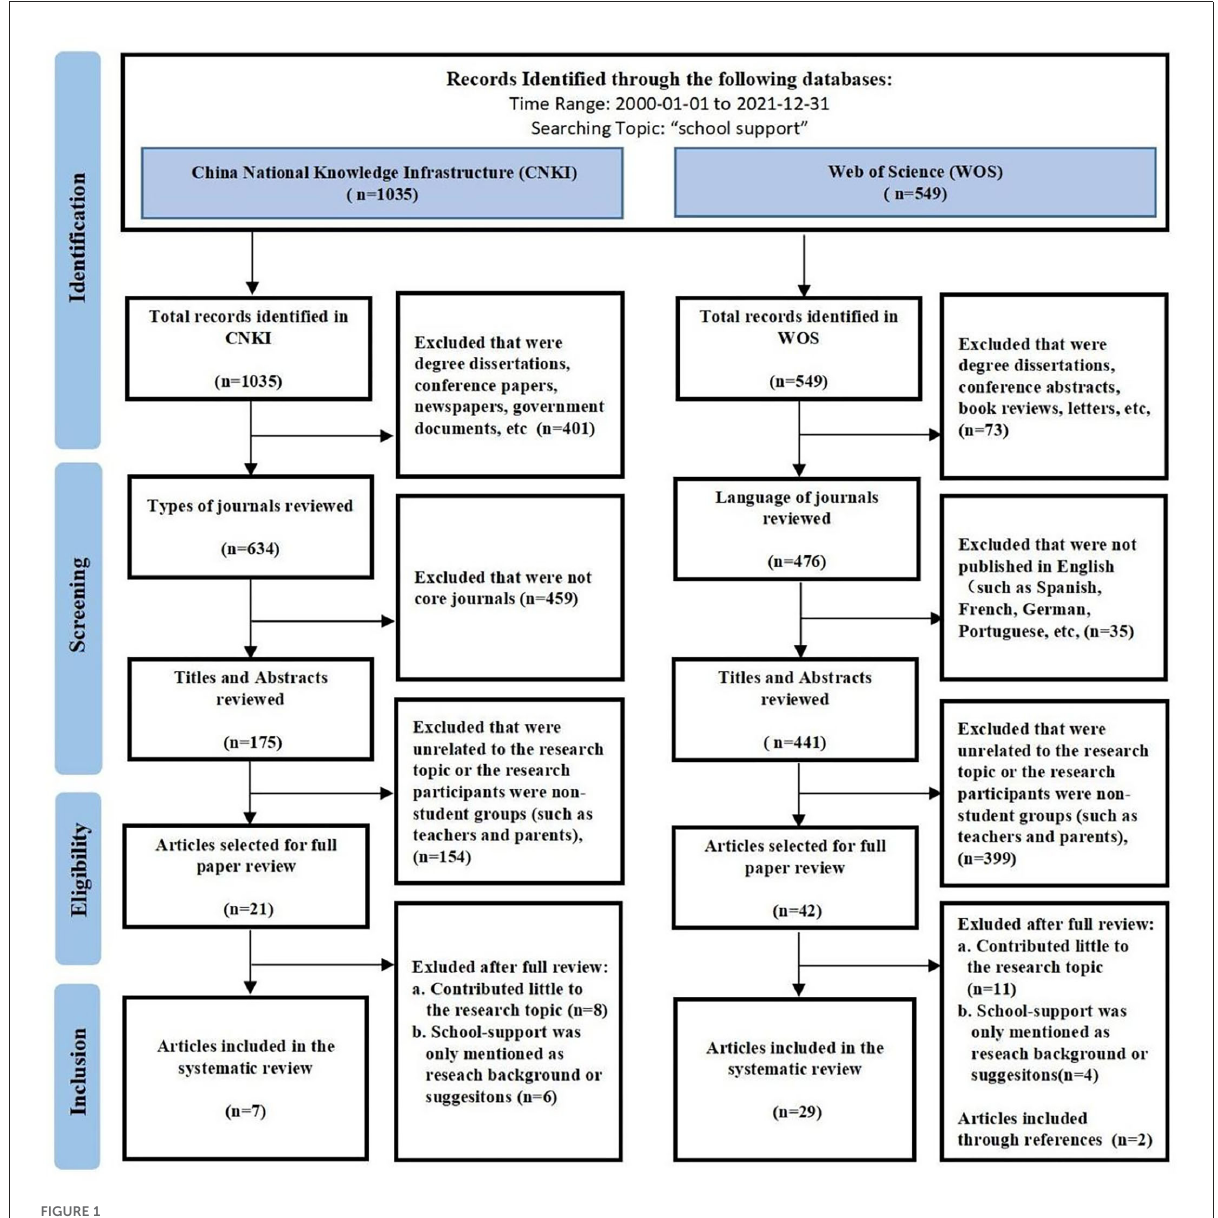
FIGURE1 Flow chart based on PRISMA